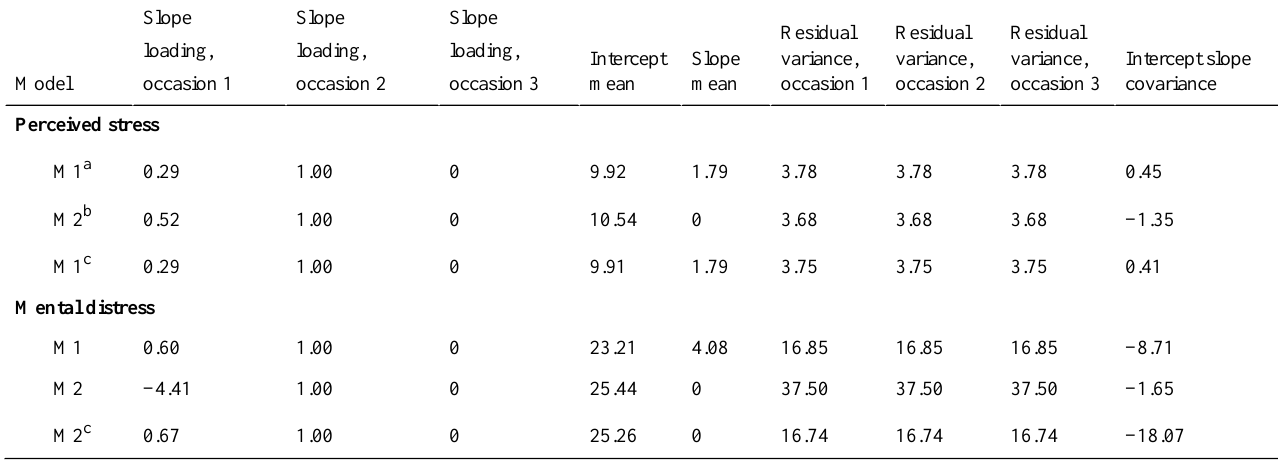
Table 5. Latent growth model summary.